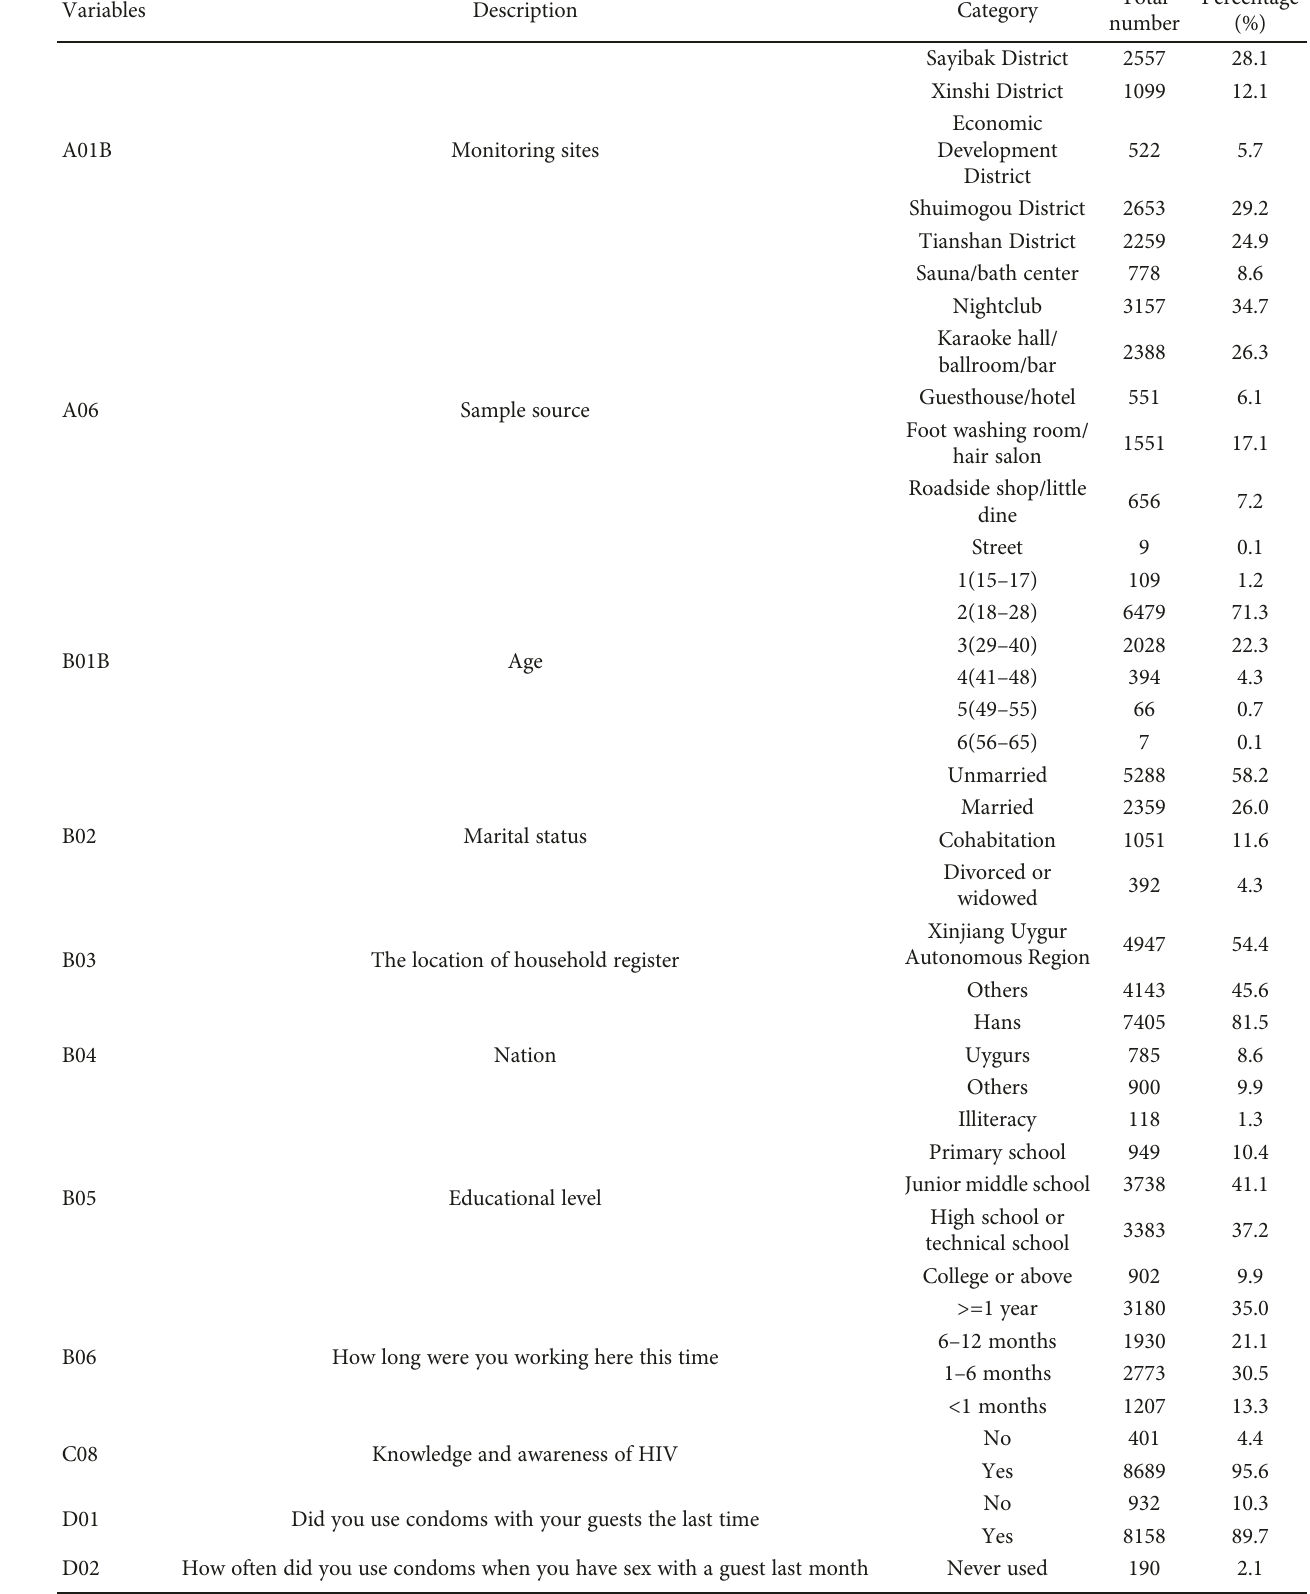
Table 2: Details of the attributes of the FSW